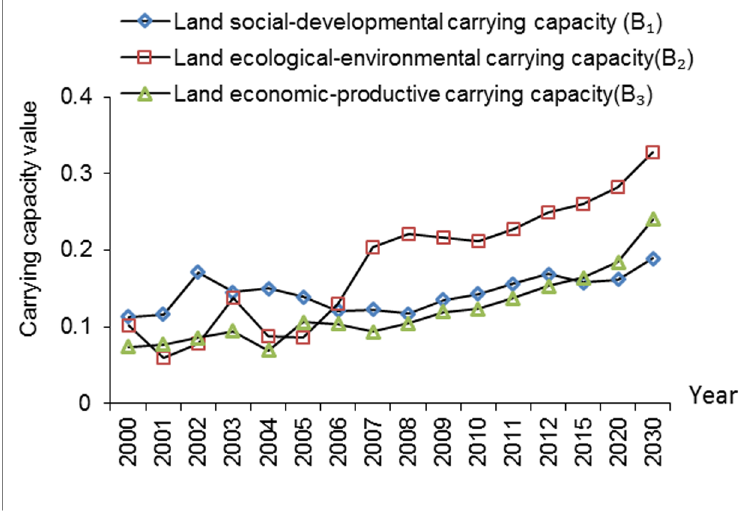
Fig 7. The social-development, ecological-environmental, and economic-productive land carrying capacity between 2000 and 2030 in Xiamen